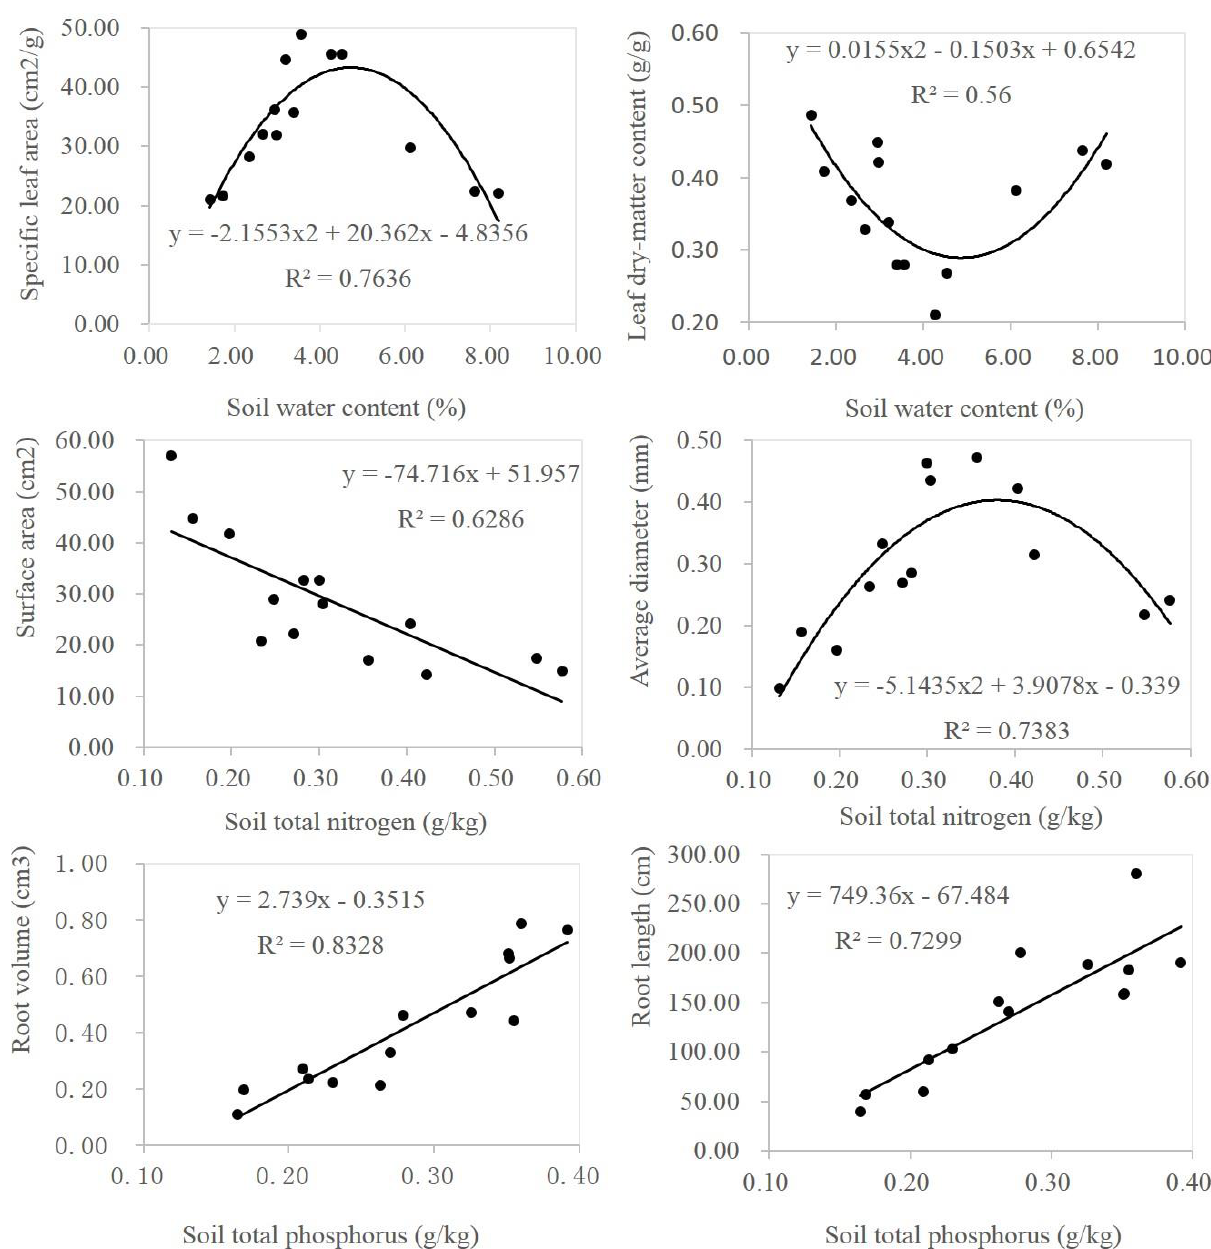
Figure 3. Fitting results of linear model for specific leaf area and soil water content, soil water content and leaf dry matter content, root surface area and soil total nitrogen, root diameter and soil total nitrogen content, average root volume and soil total phosphorus content, and root length and soil total phosphorus content.